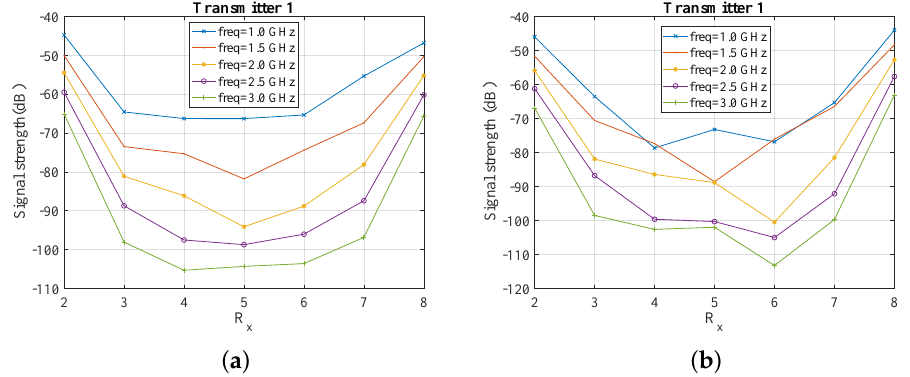
Figure 9. Received signal strength as a function of receiver number when the array is immersed in 90% glycerine–water for the experimental setup: ( a ) no target and ( b ) water